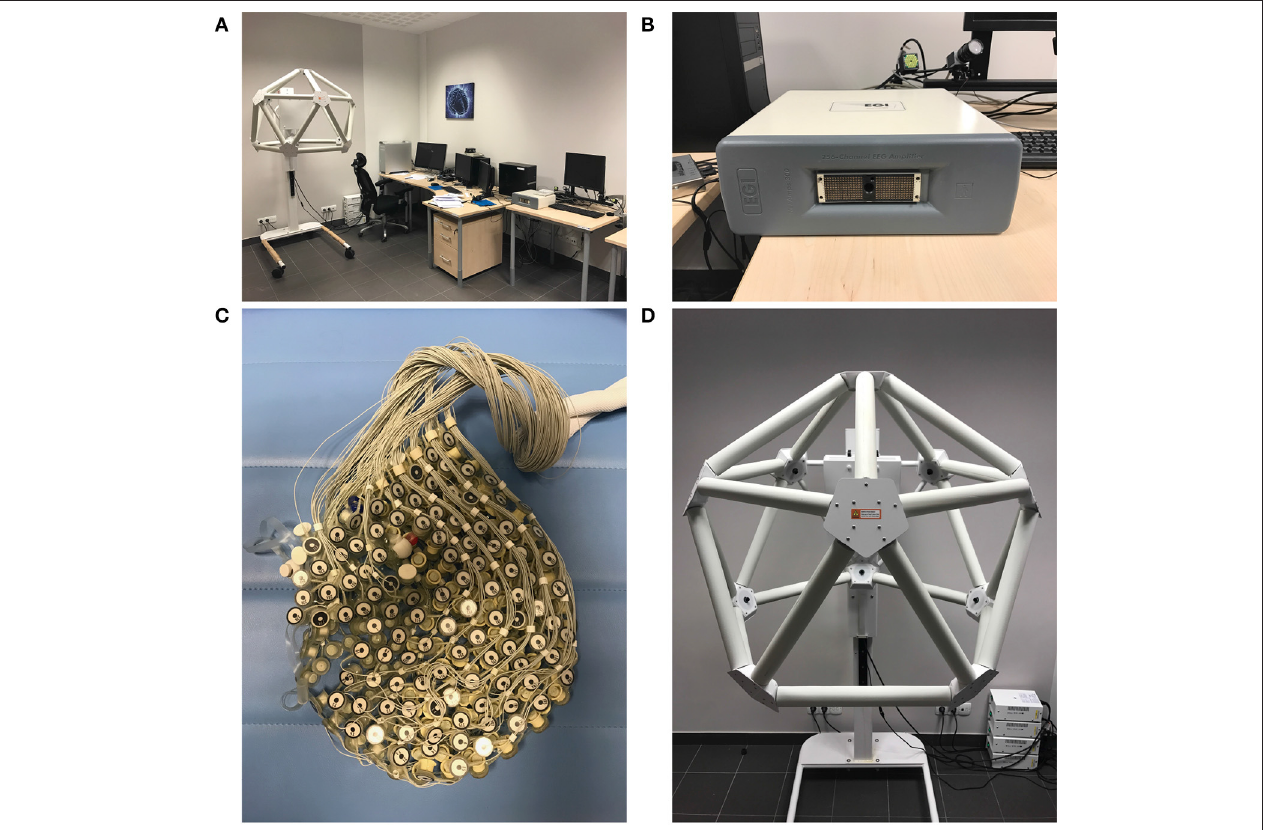
FIGURE 1 | EEG Laboratory in the Department of Neuroinfomatics. From top-left corner clockwise: (A) general view of the lab, (B) 256 channel EEG dense array amplifier, (D) GPS station equipped with 11 cameras for the GeoSource software, and (C) 256 electrodes HydroCel GSN 130 Geodesic Sensor